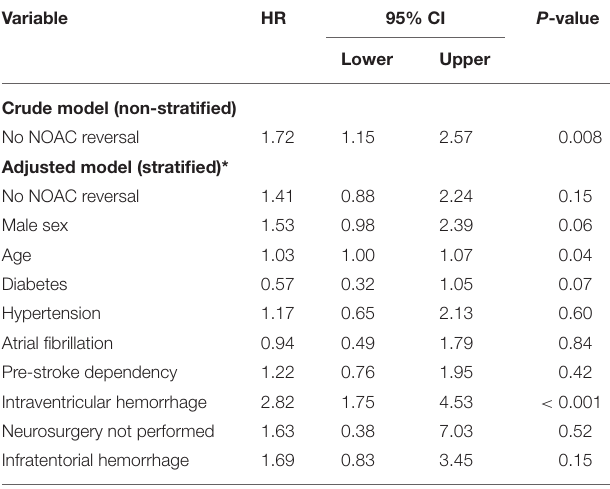
TABLE 3A | Cox regression analysis stratified for level of consciousness showing Hazard Ratios (HR) for 90-day mortality in 337 patients with VKA-ICH. Variable